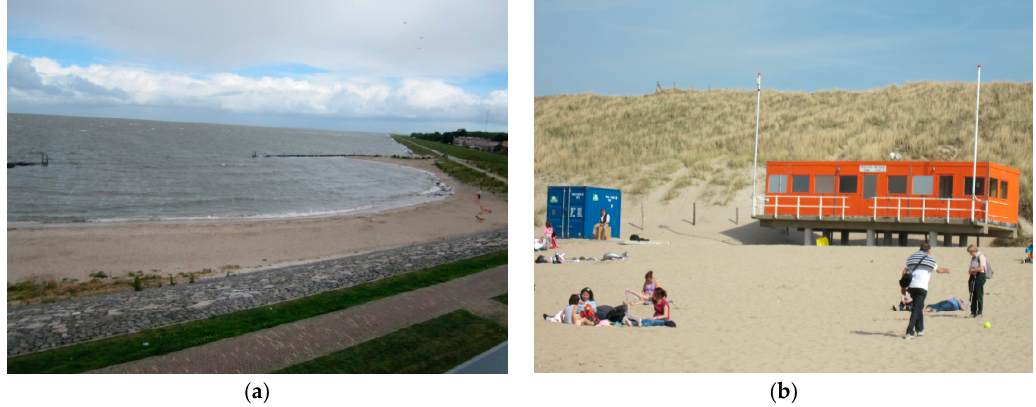
Figure 2. ( a ) A sea dike in Urk, the Netherlands; ( b ) A sand dune near Noordwijk, the